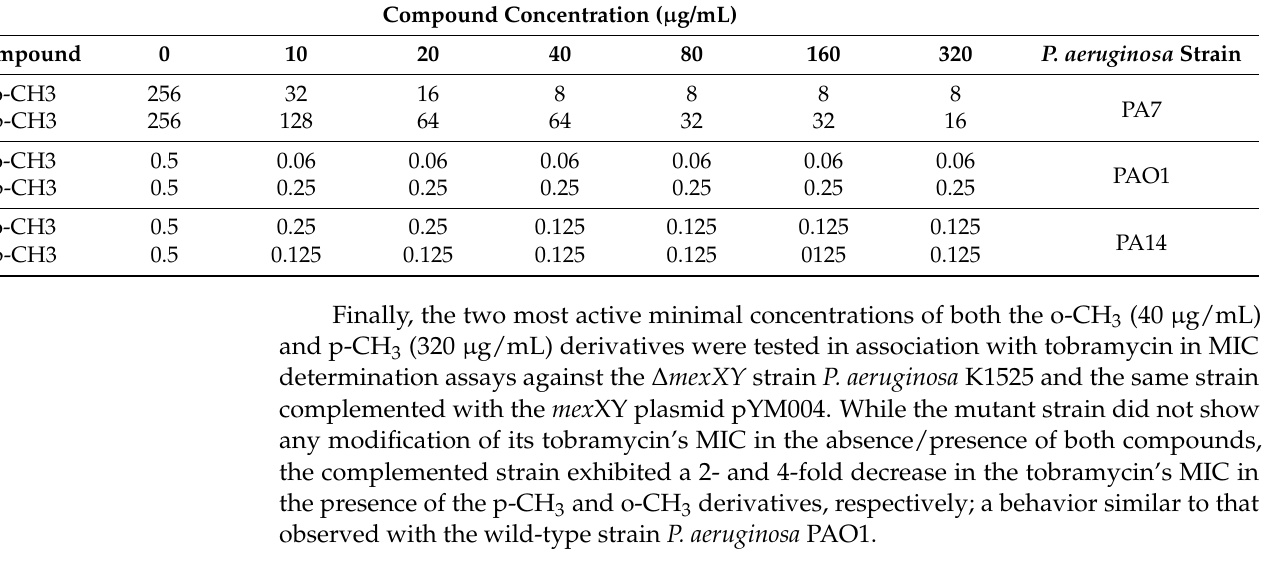
Table 5. P. aeruginosa tobramycin’s MIC reduction in the presence of double the concentrations of o-CH 3 and p-CH 3 derivatives.